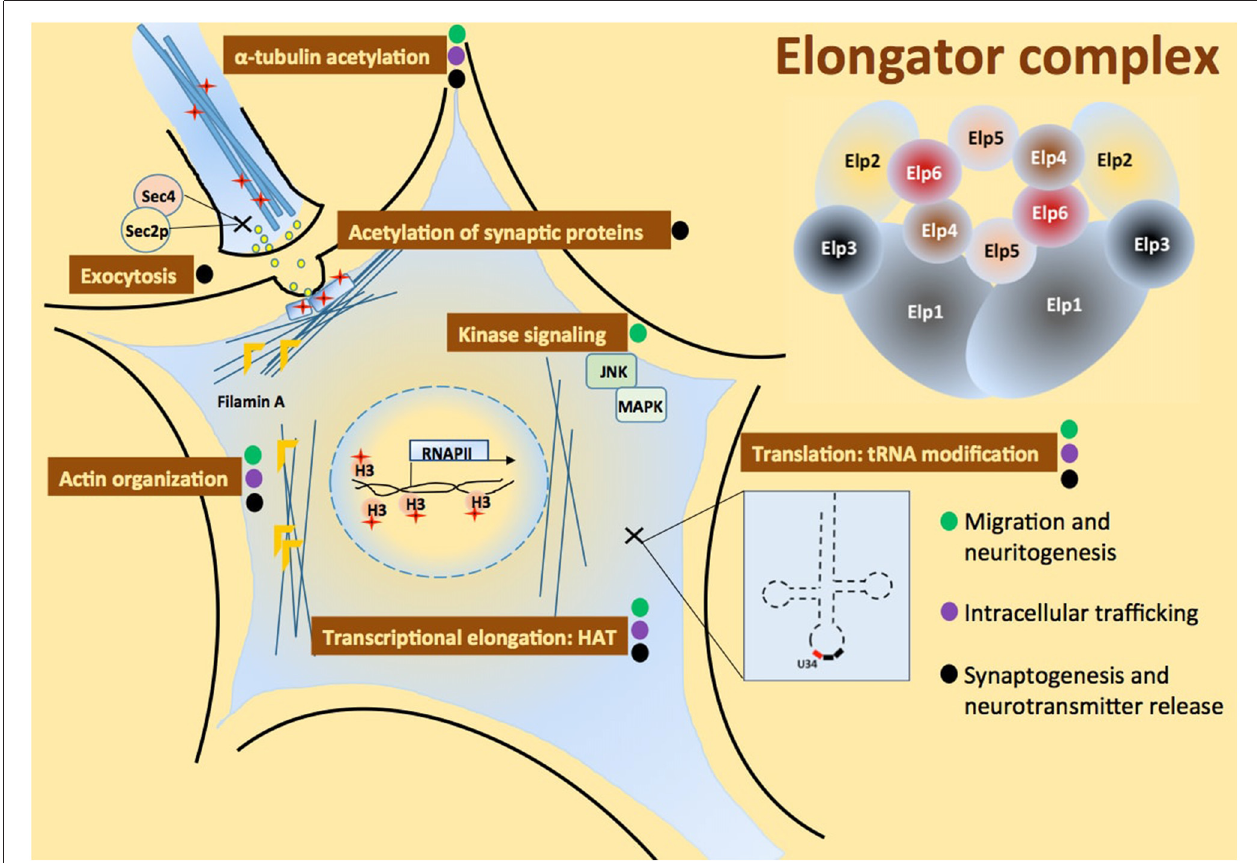
FIGURE 2 | Multiple roles of the Elongator complex in neurons. The six-subunit Elongator complex is proposed to play multiple roles in cell: a role of histone-acetyl transferase (HAT) required for transcriptional elongation, it assists c-Jun N-terminal kinase (JNK)-MAPK module assembly, negatively regulates exocytosis through Sec2p-Sec4 interaction, regulates actin organization via Filamin A, promotes α -tubulin and synaptic proteins acetylation, and modifies transfer RNA (tRNA) U 34 . Elongator functions can be associated to cell activities critical for development and maintenance of the nervous system: migration and branching of neurons, intracellular trafficking and synapse formation, marked with green, purple and black circle in the figure,